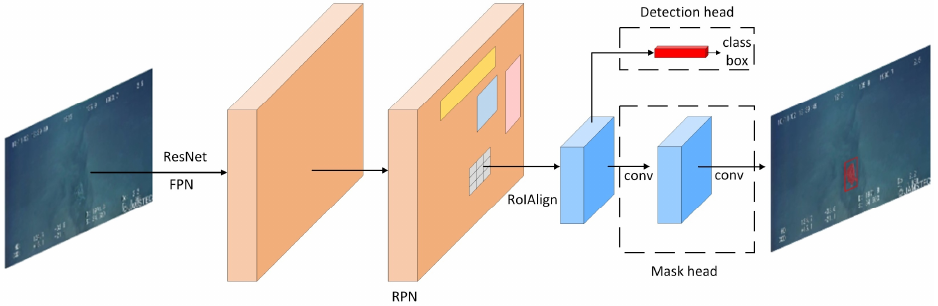
Figure 1. The structure of Mask R-CNN.